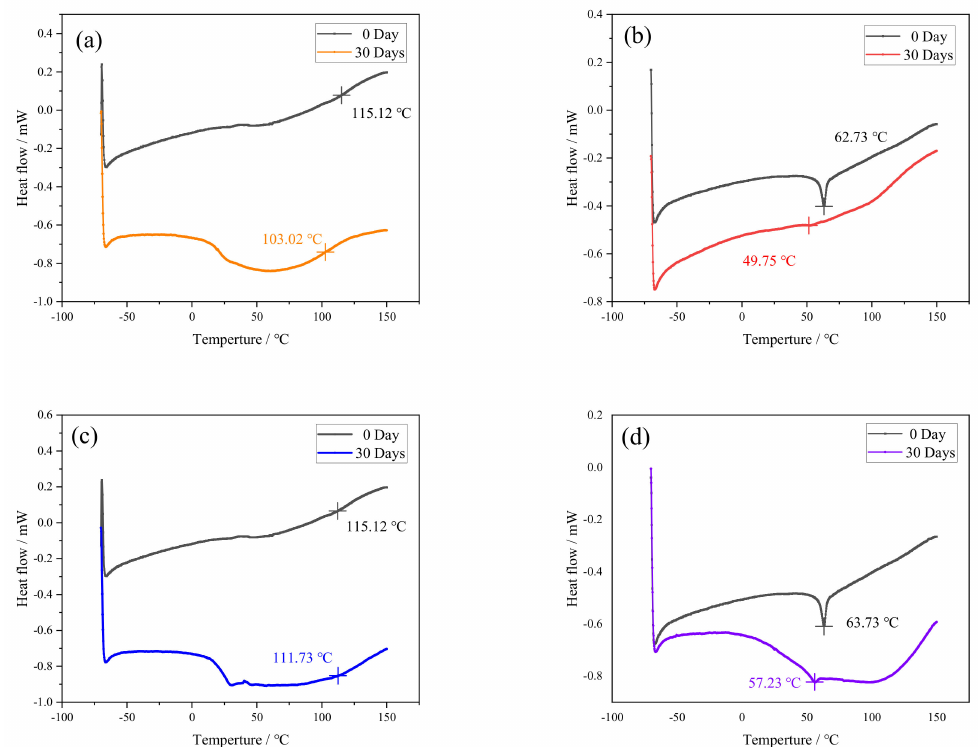
Figure 8. DSC thermogram of the adhesive: ( a ) Araldite® 2012 in 80 ◦ C/95%RH, ( b ) Araldite® 2014 in 80 ◦ C/95%RH, ( c ) Araldite® 2012 in 80 ◦ C/pure water, and ( d ) Araldite® 2014 in 80 ◦ C/pure